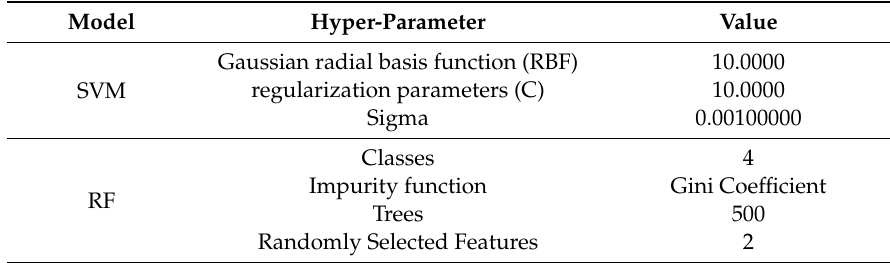
Table 5. Model hyper-parameter